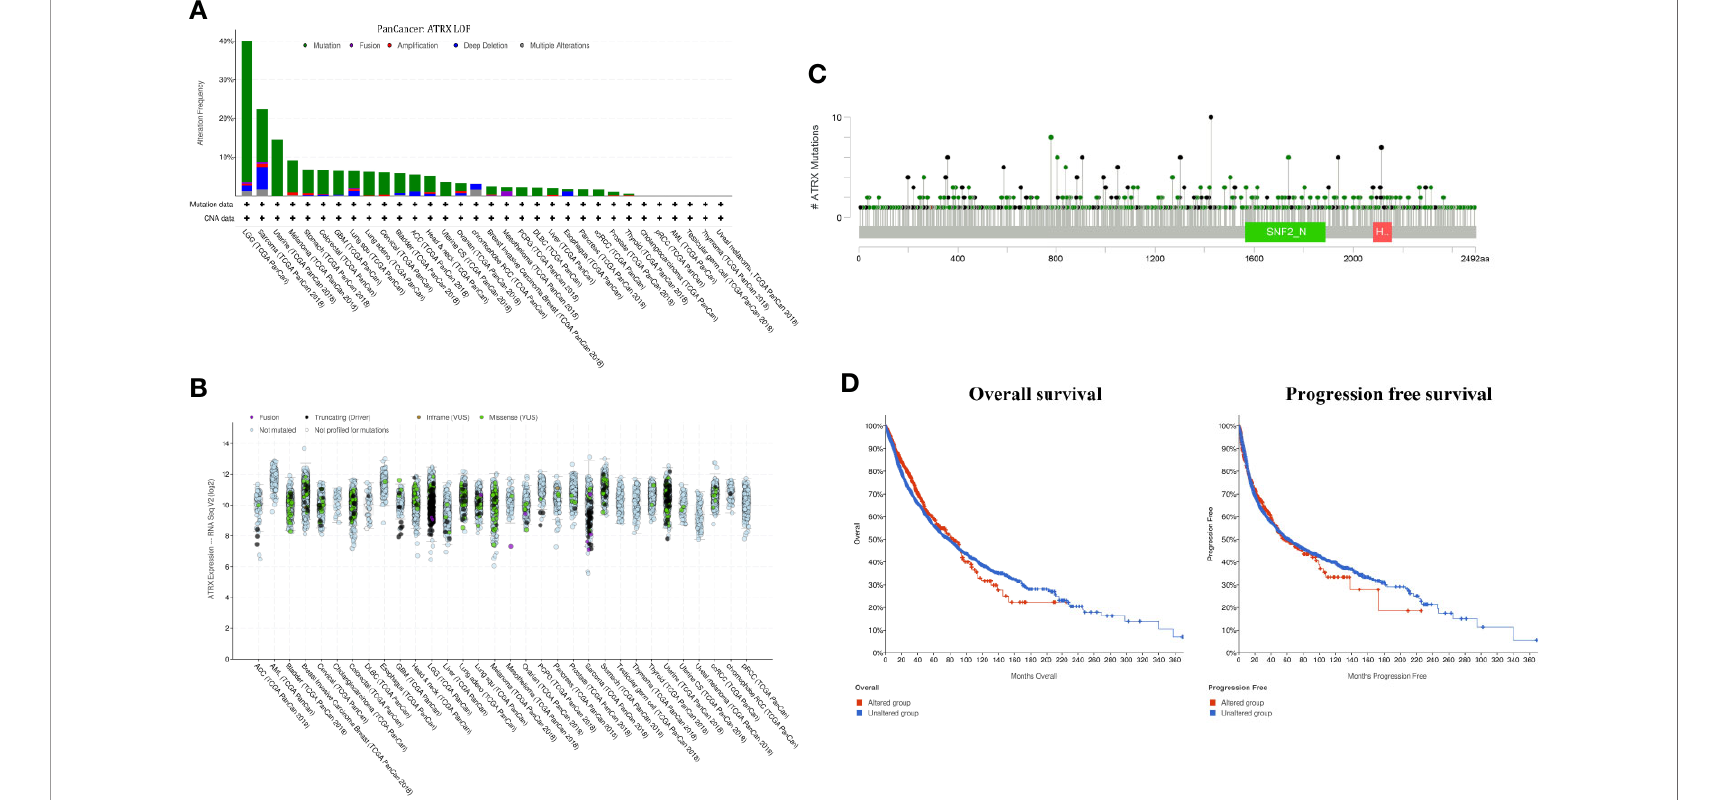
FIGURE 1 | Atrx alteration is prevalent among human cancers. (A) percentage of Atrx alteration among common human cancers. (B) Expression of different Atrx mutation forms among common human cancers. (C) the mutation site within Atrx domains. (D) Differences in overall survival and progression free survival between Atrx altered and unaltered